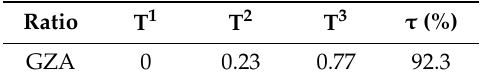
Table 1. T species silicon atom type (%) and condensation ratio of GZA sol-gel network.